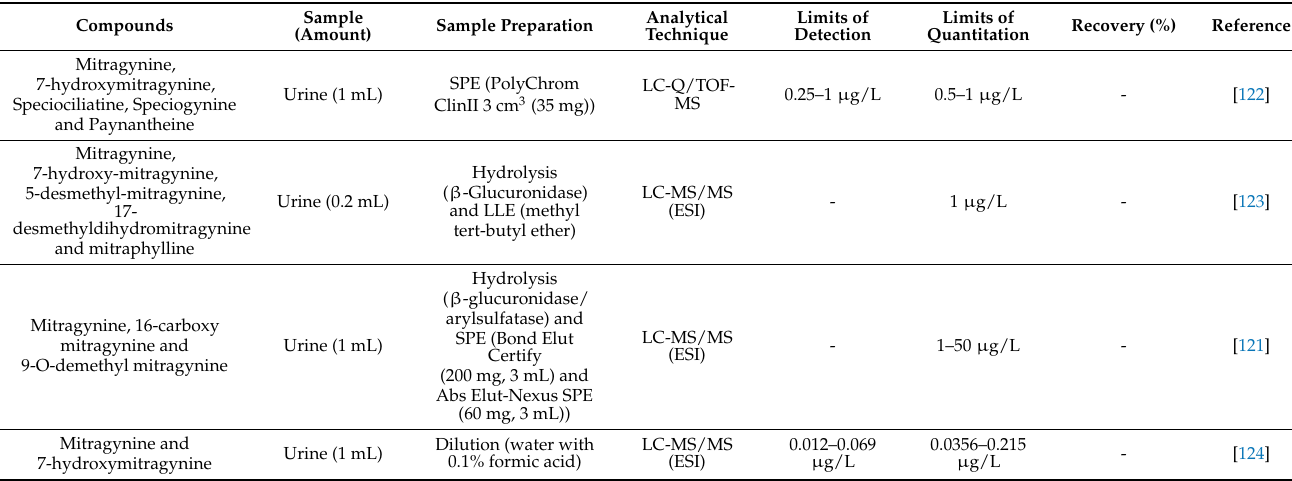
Table 5. Analytical methods for the determination of the main components of Mitragyna speciosa .